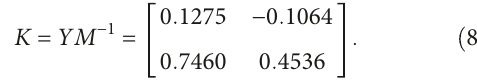
Figure 2: γ versus α .